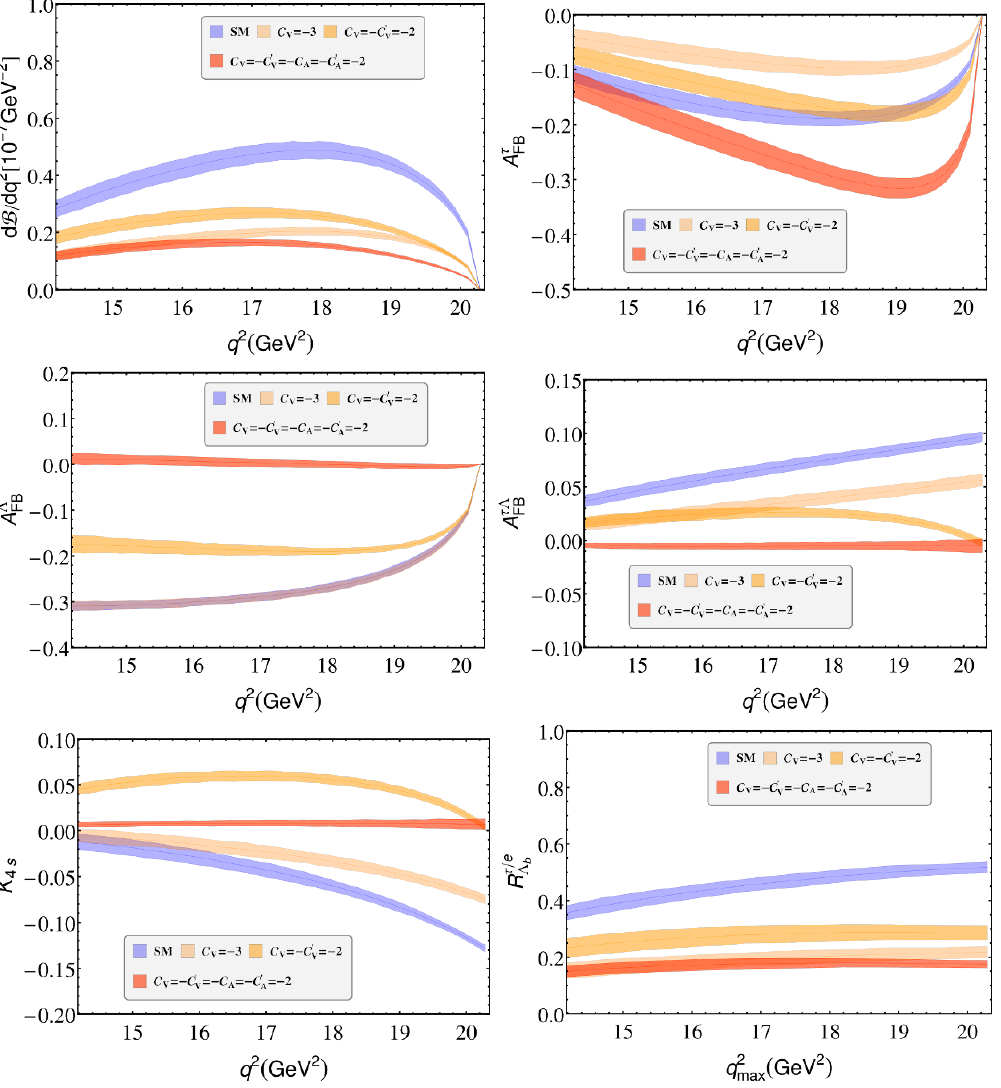
Figure 3 . The (cid:3) b ! (cid:3)( ! p(cid:25) ) (cid:28) + (cid:28) (cid:0) observables in the presence of VA couplings. The bands correspond to the uncertainties discussed in text. Since the OPE at large q 2 does not capture local resonance structures, the distributions can be locally o(cid:11) from the OPE